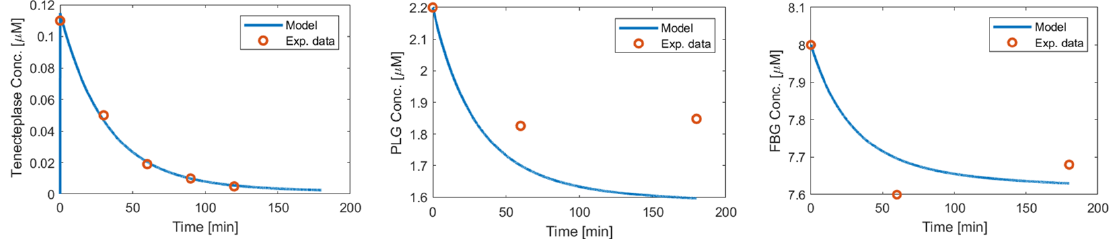
Figure A1. Comparison between simulation results and clinical results from TIBI 10B trial [38].